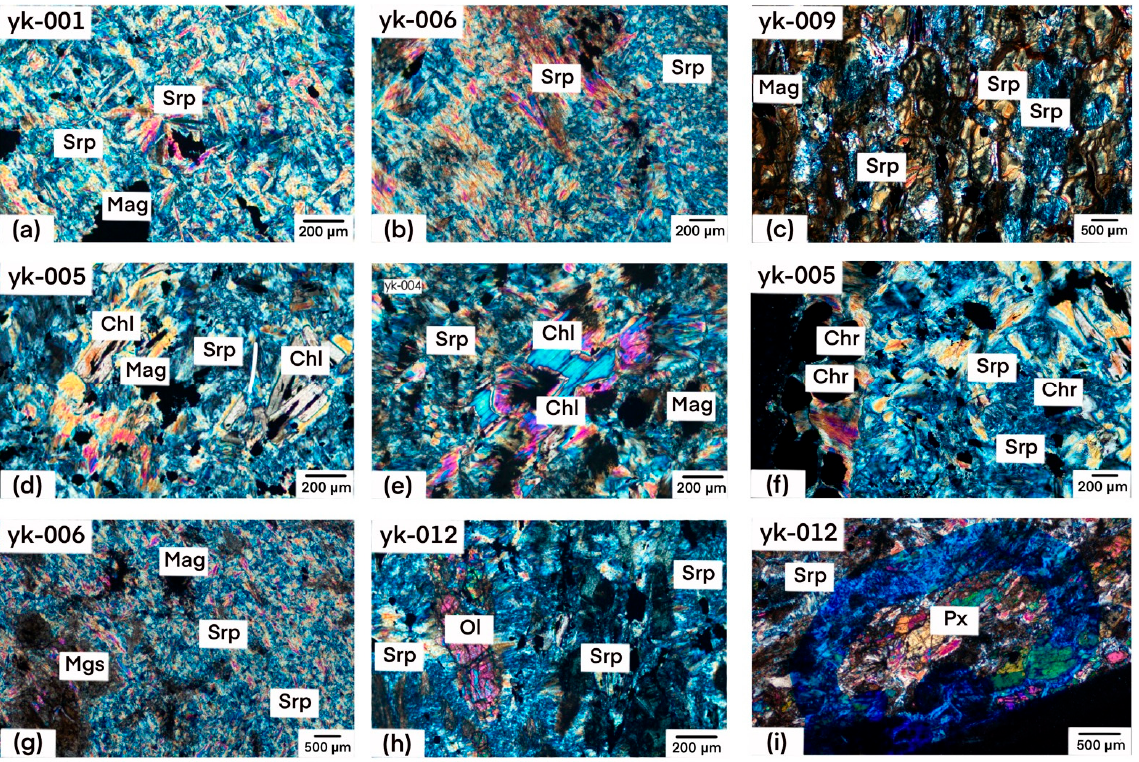
Figure 3. Photomicrographs of “Laoshan Jade” (crossed-polarized light). ( a , b ) Lepidoblastic texture and foliaceous-lamellar crys-talloblastic texture, flaky and leaf-like serpentine; ( c ) Granoblastic texture, granular serpentine with the pseudomorph of olivine; ( d ) Chlorite and disseminated ferrous metal minerals; ( e ) Chlorite with the pseudomorph of pyroxene; ( f ) Ser-pentine and subrounded ferrous metal minerals; ( g ) Xenomorphic granular magnesite; ( h ) Hypidiomorphic granular ol-ivine; ( i ) Hypidiomorphic-xenoblastic columnar pyroxene.